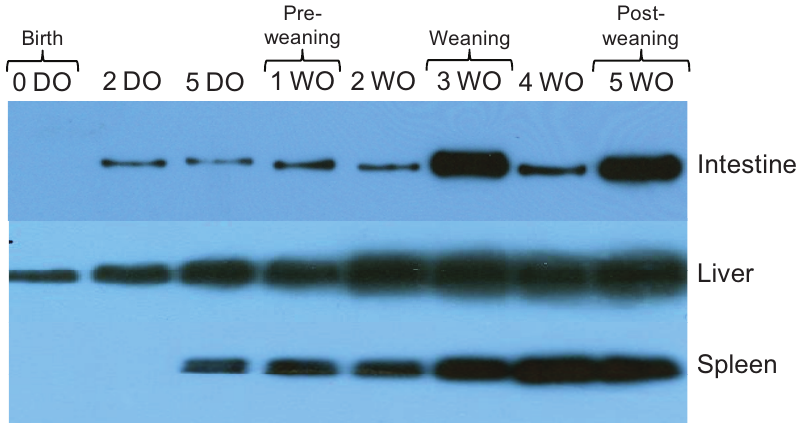
Figure 3. Western blot analysis of affinity purified 19S proteasome subunit